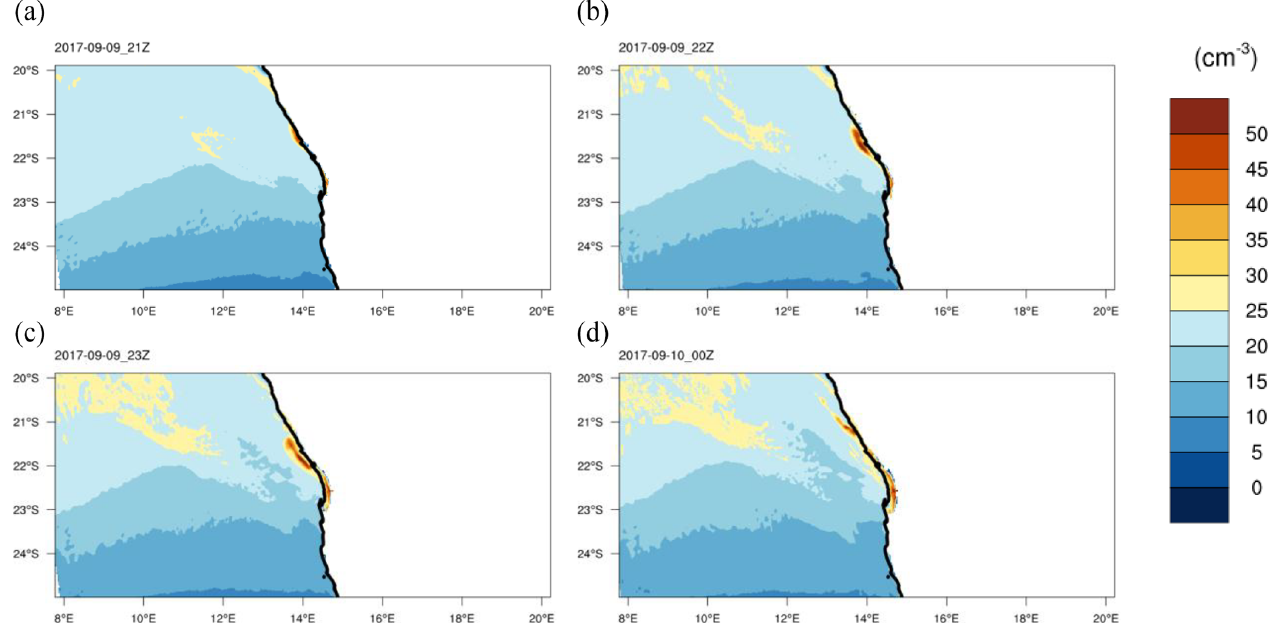
Figure 12. Cloud droplet concentration (cm − 3 ) onset for the event on 10 September 2017 for scenario CCN_300. The black dot is Henties Bay. Time is in UTC (site is UTC + 2).